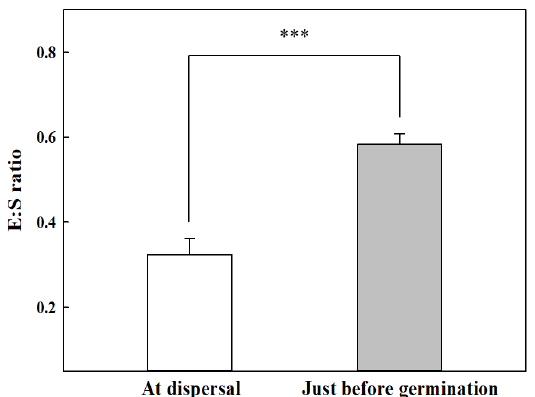
Figure 3. Embryo/seed (E:S) ratios in the seeds of Gentiana triflora var. japonica (Kusn.) H. Hara at seed dispersal and just before germination. Vertical bars represent the standard deviation from the mean ( n = 10). Each E:S ratio at dispersal and just before germination was compared using a paired t -test. *** Significant at p ≤ 0.001.